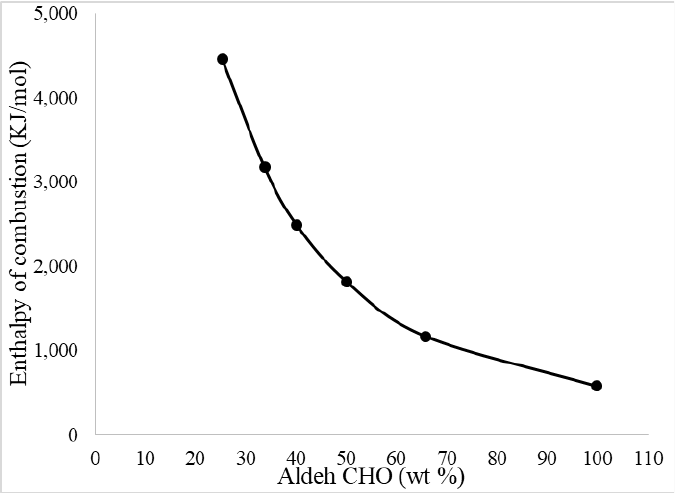
Figure 8. The effect of weight percentage of CO on enthalpy of combustion for ketones.